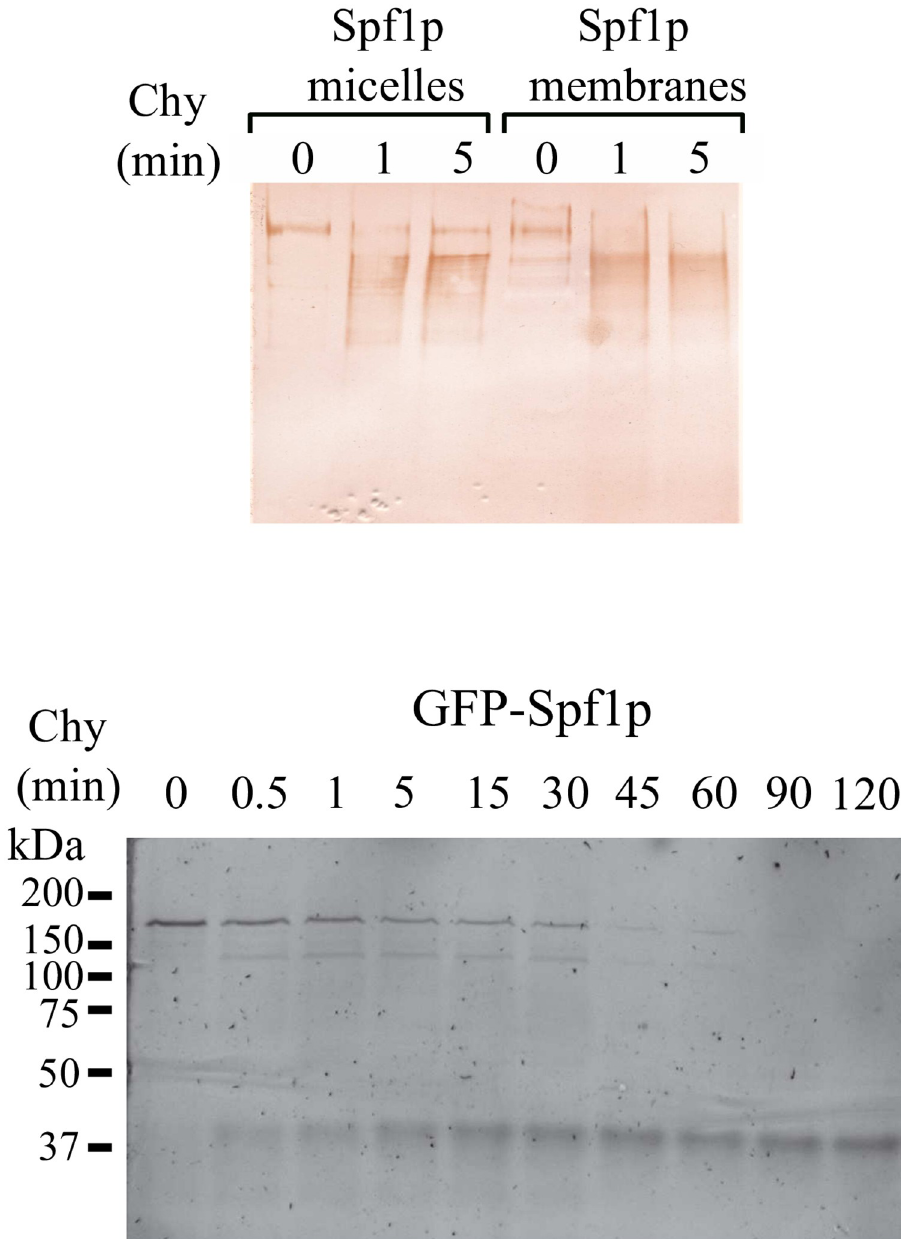
Fig 4. Chymotryptic digestion of detergent-purified Spf1p and Spf1p from yeast membranes. Top panel , 0.1 μ g of purified Spf1p in mixed detergent-lipid micelles, and 20 μ g of total S . cerevisiae membranes containing Spf1p were treated with chymotrypsin for the time indicated on top of each lane. The reaction was stopped by the addition of 4 μ g of aprotinin. The samples were run in a 9% SDS-PAGE and the Spf1p peptides detected by Western blot using an anti- Spf1p polyclonal antibody. Lower panel , 20 μ g of total S . cerevisiae membranes containing GFP-Spf1p were treated with 0.5 μ g of chymotrypsin for the time indicated on top of each lane. The samples were run in a 9% SDS-PAGE and the gel was scanned for GFP